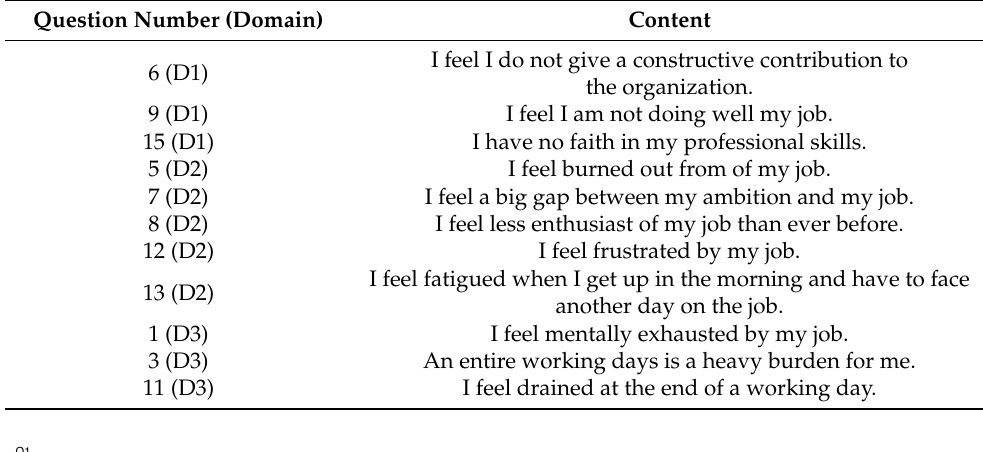
Table 4. Questions included in the identified domains.